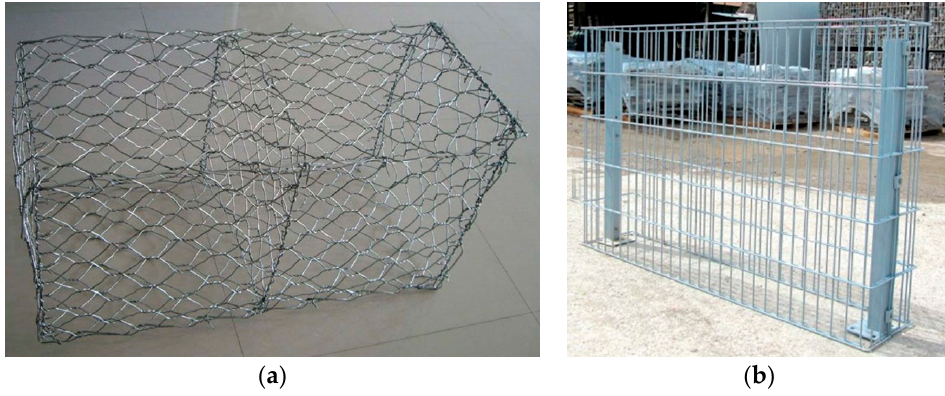
Figure 2. The building’s cross-section.